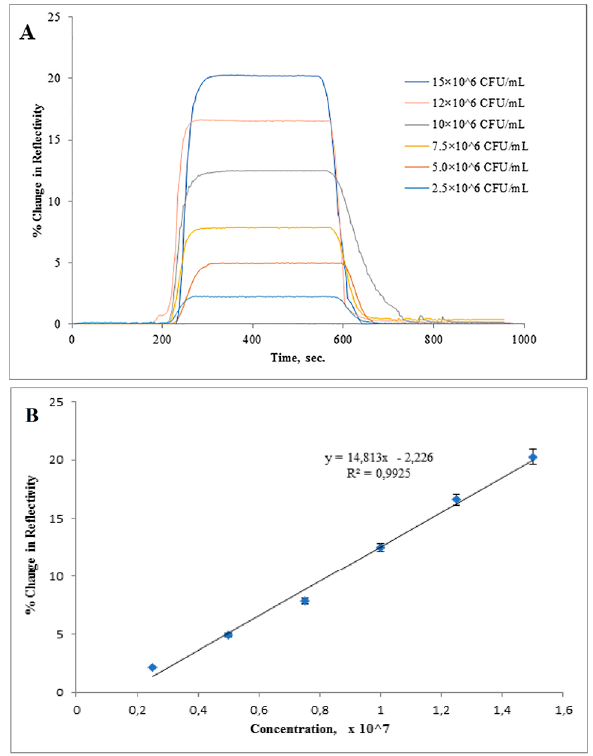
Figure 4. Real time responses of ( A ) microcontact S. paratyphi imprinted SPR sensor at different concentrations of S. paratyphi , ( B ) calibration curve of S. paratyphi obtained at a concentration of (0.25 × 10 7 –1.5 × 10 7 CFU/mL) under experimental conditions, sample concentration: 1.5 × 10 7 CFU/mL, flow rate: 200 µL/min, running buffer: PBS buffer, regeneration buffer: 10 mg/mL lysozyme solution, 50% ethyl alcohol.